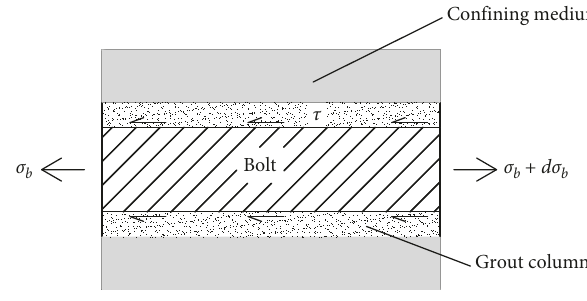
Figure 2: Cross section view of a rock bolting system.